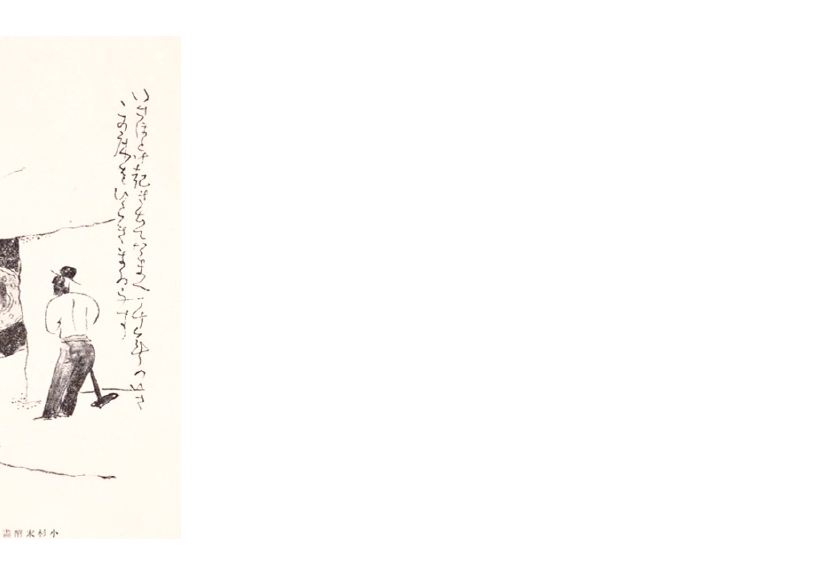
Figure 3. Frontispiece illustration. Drawing by Kosugi Misei. Pastimes of Ky ŏ ngju , 1931.